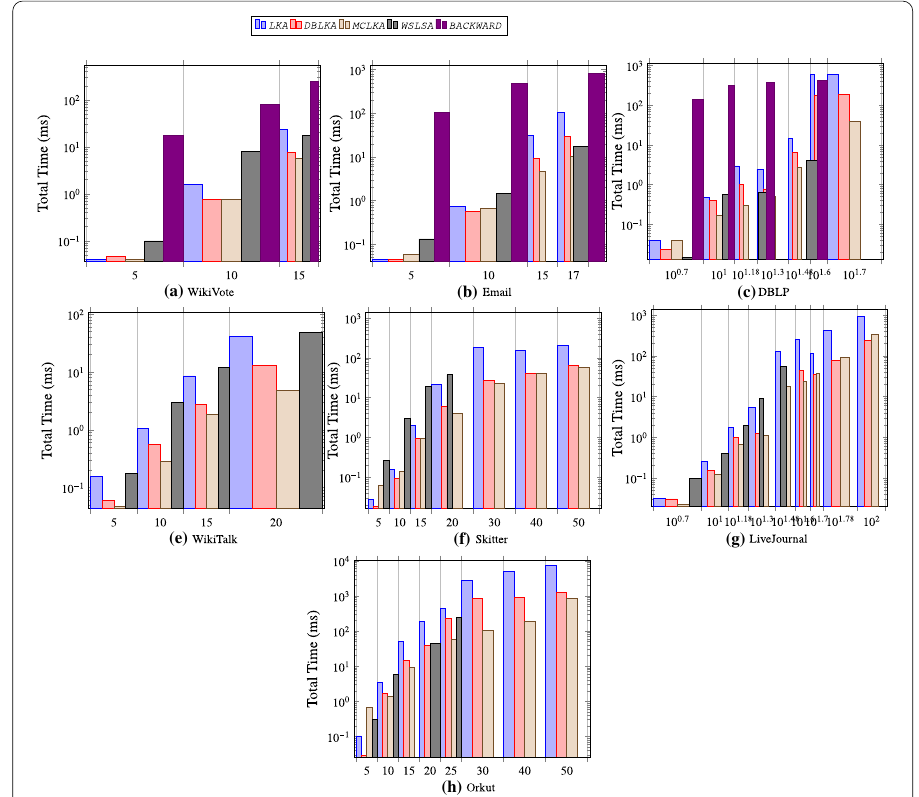
Fig. 10 Execution time of the proposed algorithms against Backward and WSLSA Algorithms while r and k is